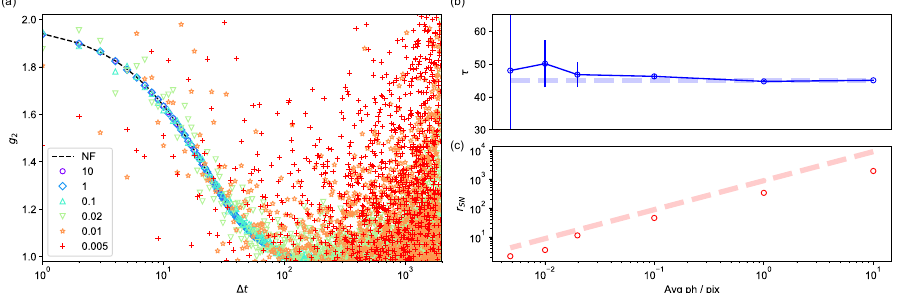
Figure 2. ( a ) Colored symbols show g 2, SIM calculated from the 2D diffusion simulation using the R = 30 ROI with various average intensities, fixed for all speckle patterns. The average number of photons per pixel (cid:104) I t (cid:105) is given in the legend. The “noise free” g 2, NF is plotted using the black dashed curve as a reference. ( b ) The τ SIM obtained from fits to the data in ( a ) as a function of (cid:104) I t (cid:105) , with the dashed line marking τ NF . ( c ) The signal-to-noise ratio r SN as a function of (cid:104) I t (cid:105) , extracted from the simulated dataset (colored symbols) and calculated from Equation (5) (dashed